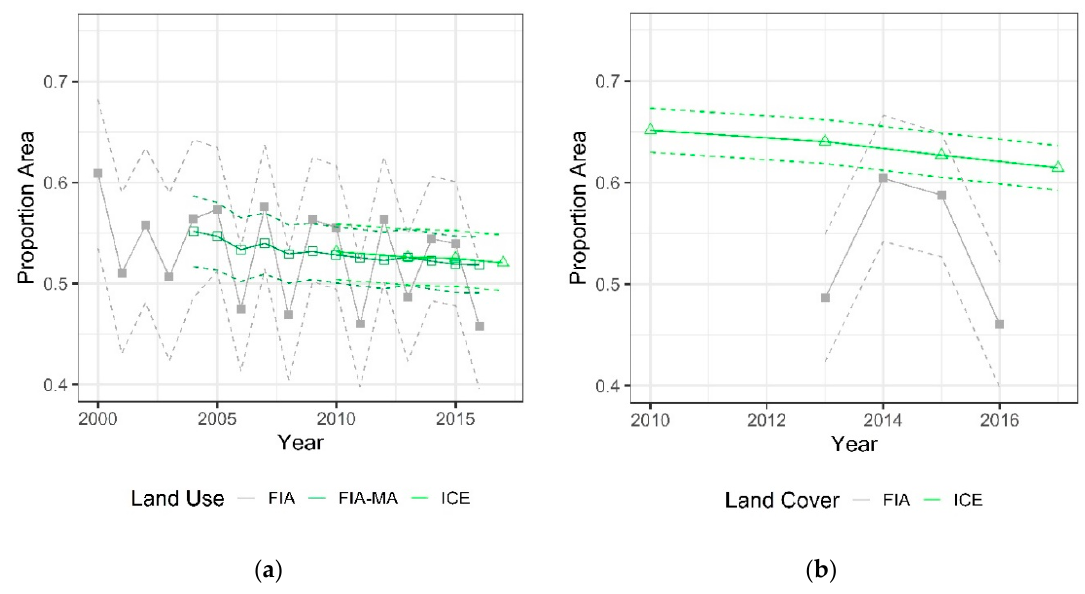
Figure 5. ( a ) The estimated proportion of land area in forest land use, with 95% confidence interval, by year using FIA plots alone (gray closed squares), FIA moving average (medium green open squares), and ICE (light green open triangles). ( b ) The same as ( a ) but for tree cover. Note that FIA land cover data were only collected for 2013-2016 so the five-year moving average could not be calculated.